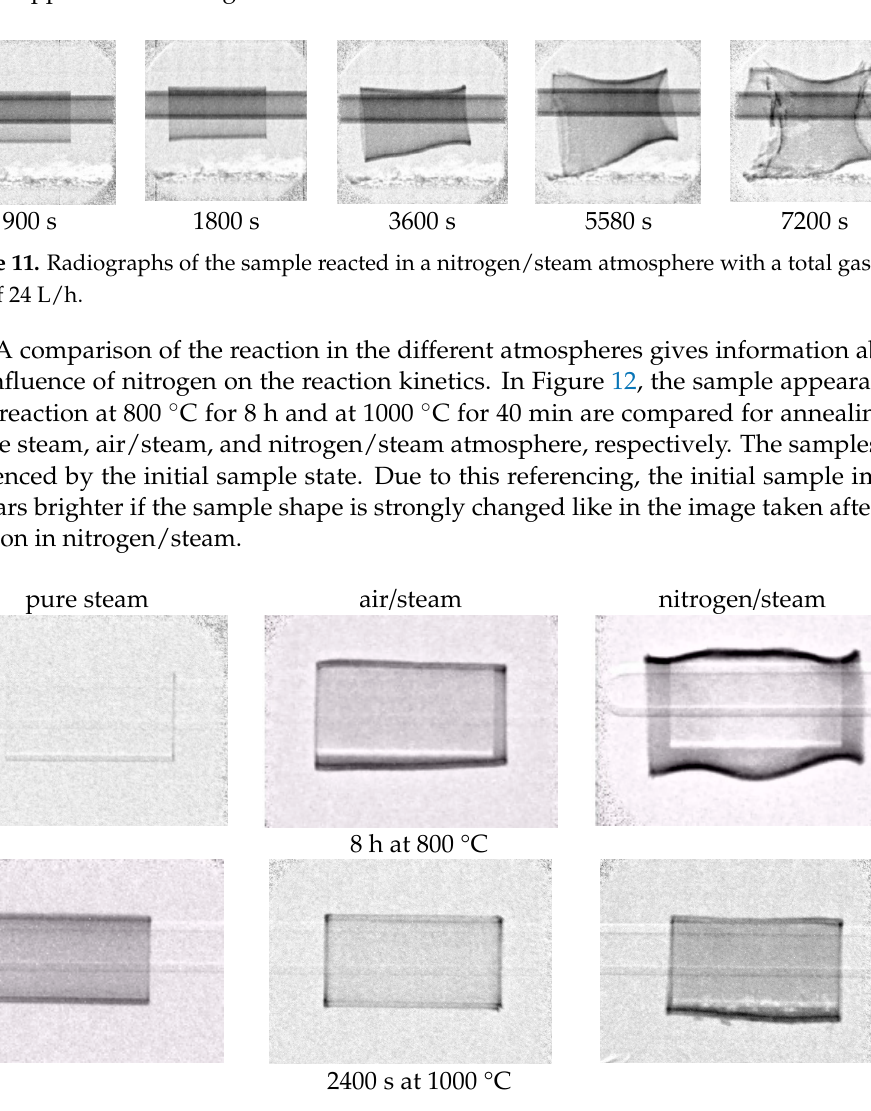
Figure 12. Comparison of neutron radiographs taken after 8 h reaction at 800 °C and 40 min at 1000 °C in pure steam, air/steam, and nitrogen/steam mixtures (flow rates of 2 g/h H 2 O and 10 L/h nitrogen or oxygen flux, respectively).